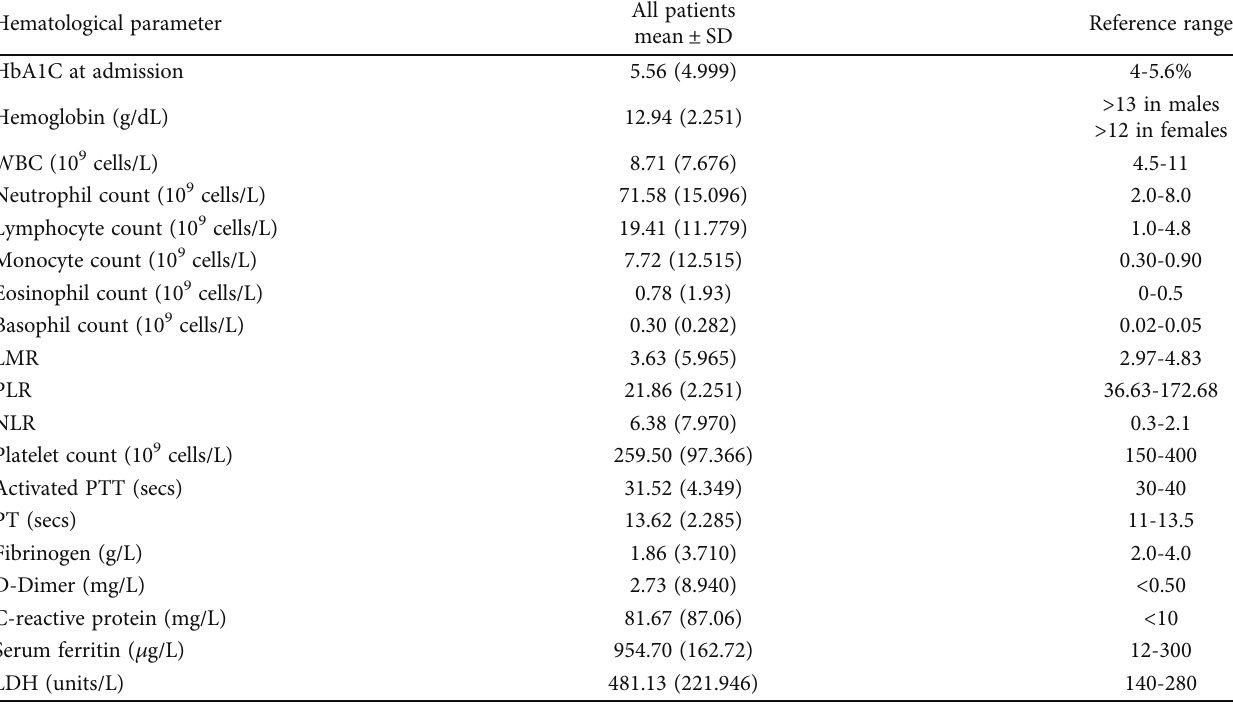
Table 2: Hematological parameters of all patients with COVID-19 infection and diabetes mellitus at the time of admission. Hematological